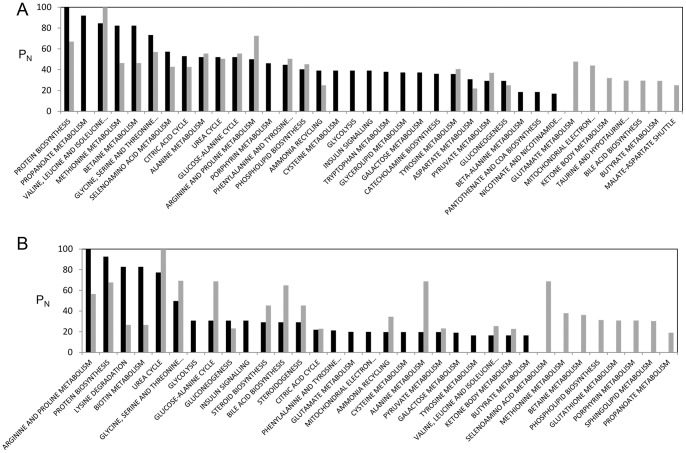
Summary of the relatively enriched pathways urine (A) and serum (B) samples based on gender.The log values of – (Holm p-value) are normalized (PN) within the same gender to enable the direct comparison of the relatively enriched metabolic pathways between male and female. The pathways for male and female are shown as black and gray bars, respectively.